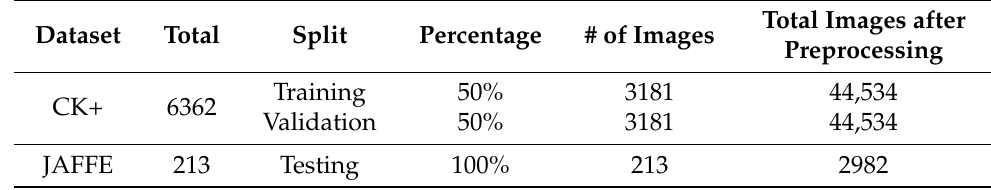
Table 16. Division detail along with numbers of images per set for cross dataset